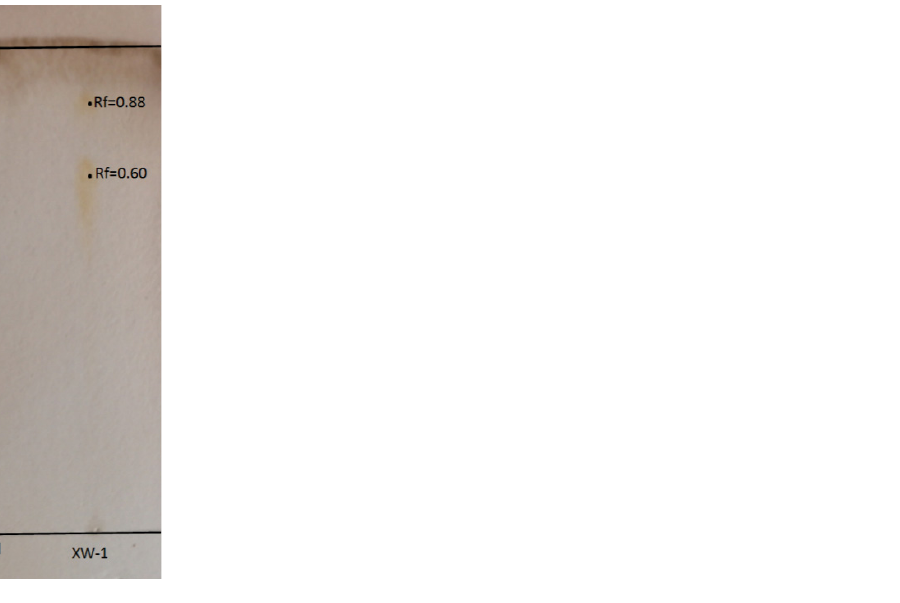
Figure 3. The result of detecting biosurfactant XW-1 by TLC. Without adding biosurfactant were set up as negative control.